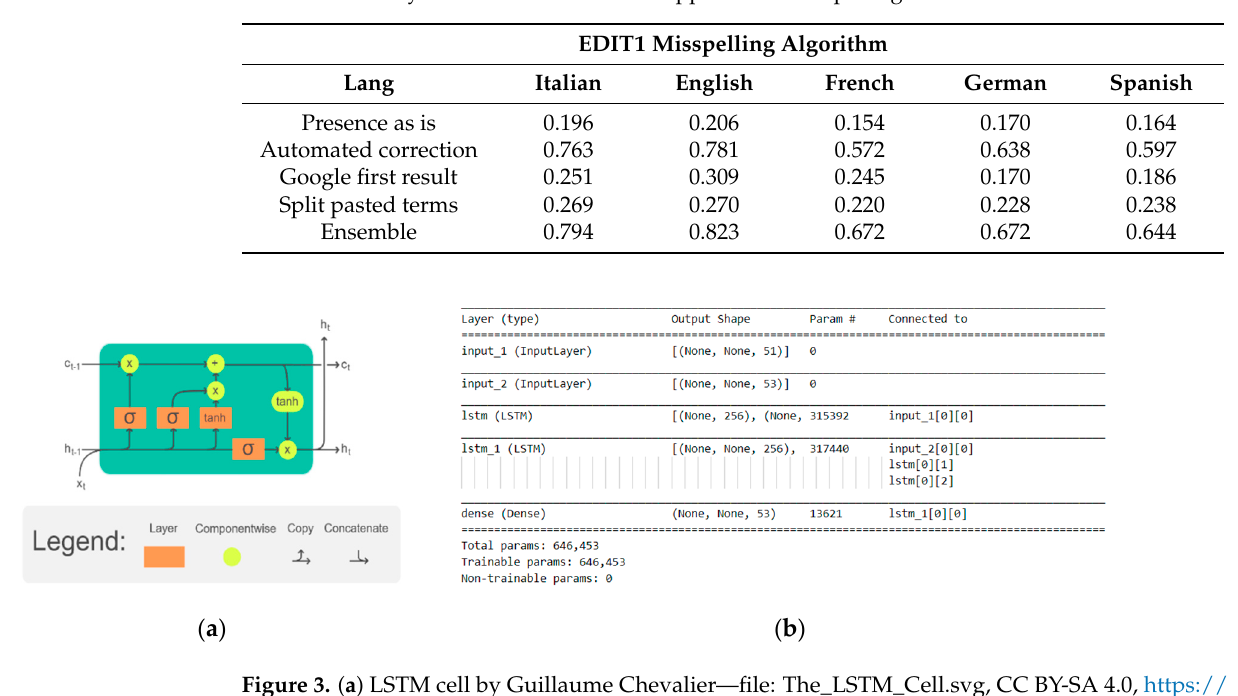
Table 6. Accuracy values for the statistical approach to misspelling correction.